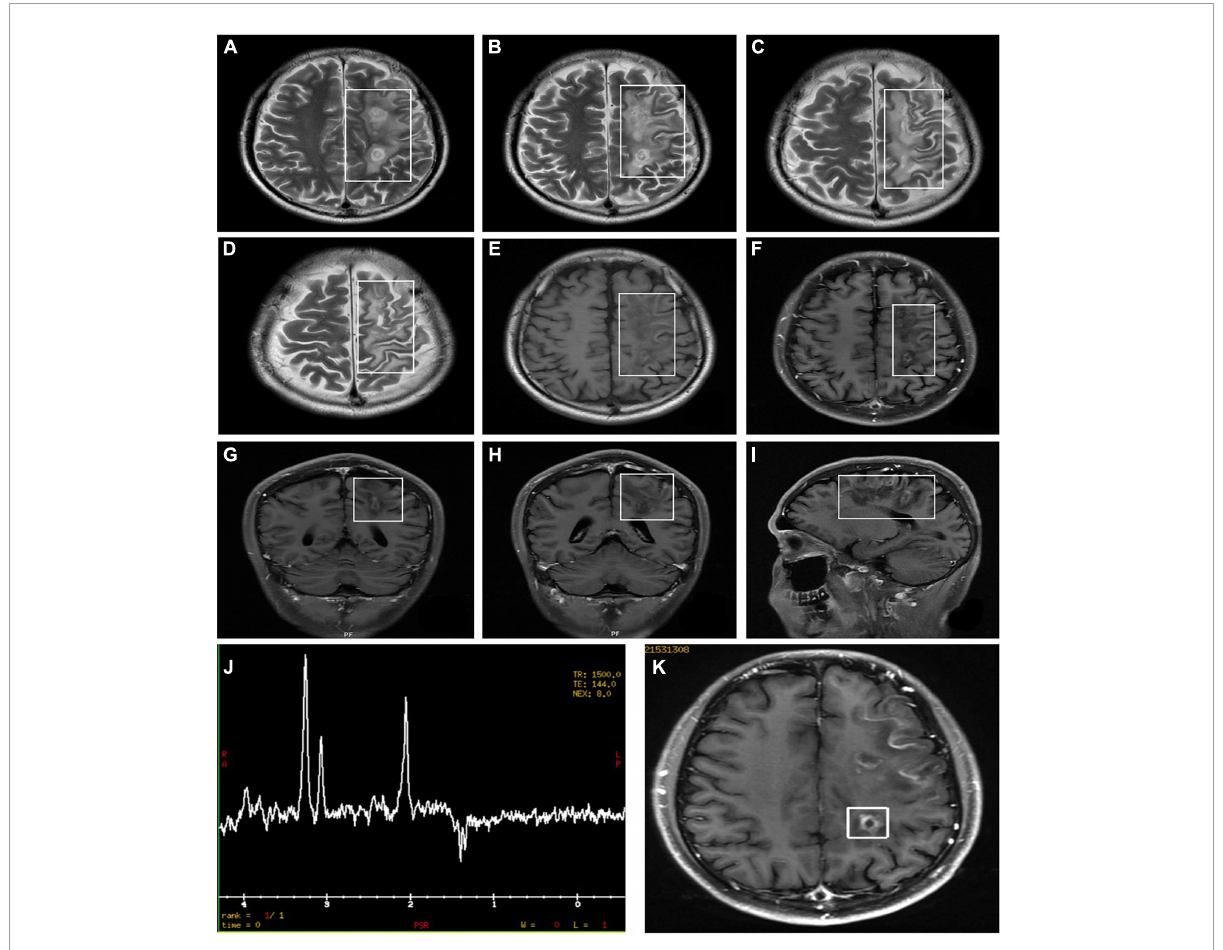
FIGURE4 Orbital MRI images in patients who were diagnosed with LHON-MS (case 9). The figure showed multiple lesions presented with an abnormal signal (A–I) . MRI findings (K) and Proton Magnetic Resonance Spectroscopy (H-MRS) findings (J) in the proband of Pedigree 1—multiple demyelinating lesions in the left cerebrum (MRI) and an inverted double peak of lactic acid (Lac) at 1.33 ppm